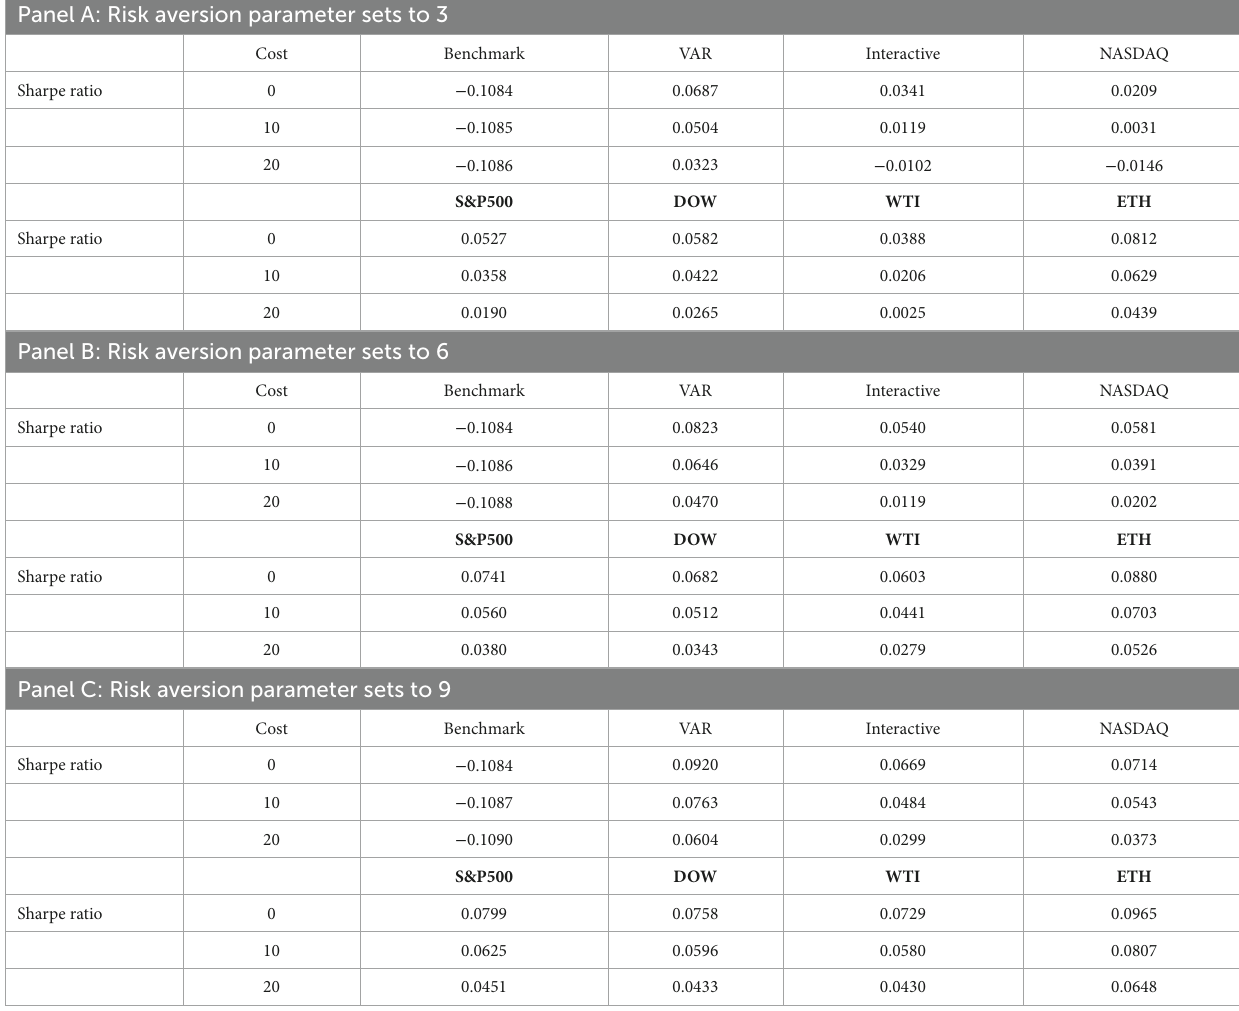
TABLE 10 Portfolio performance measures: the perspective of Sharpe ratio. Panel A: Risk aversion parameter sets to 3